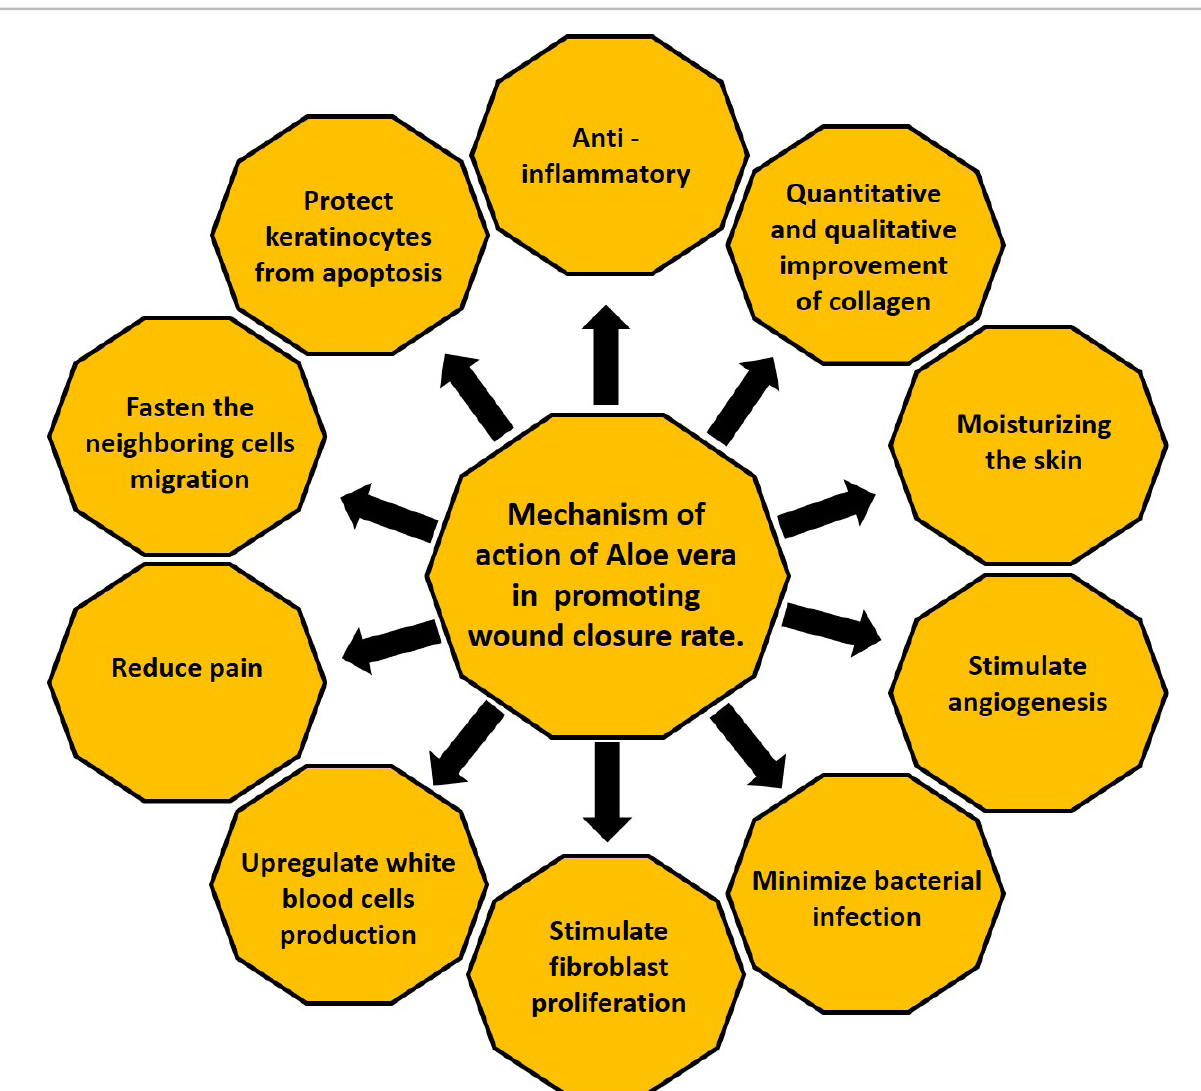
FIGURE 3 - Action mechanism of Aloe vera in promoting wound